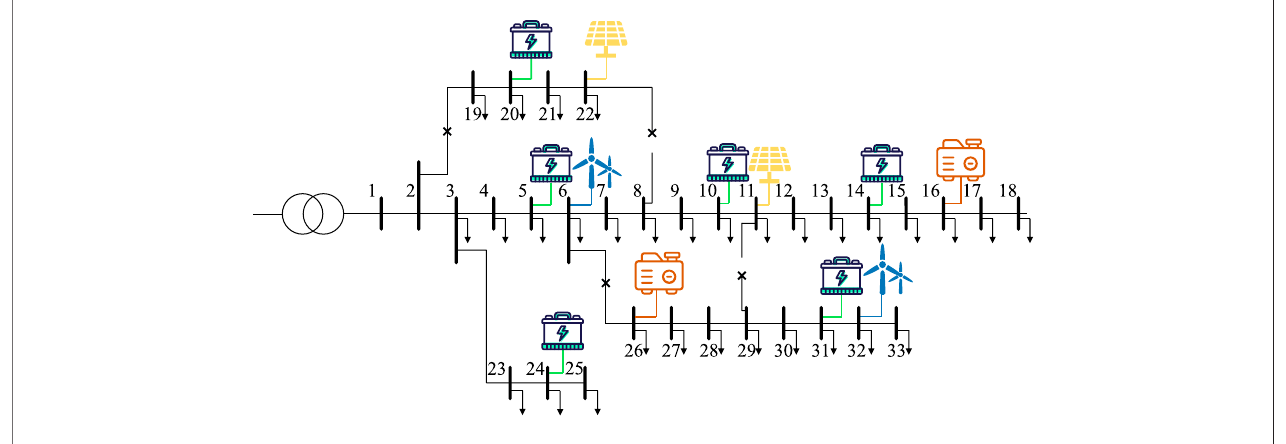
FIGURE 2 | Modi fi ed IEEE 33-bus system.